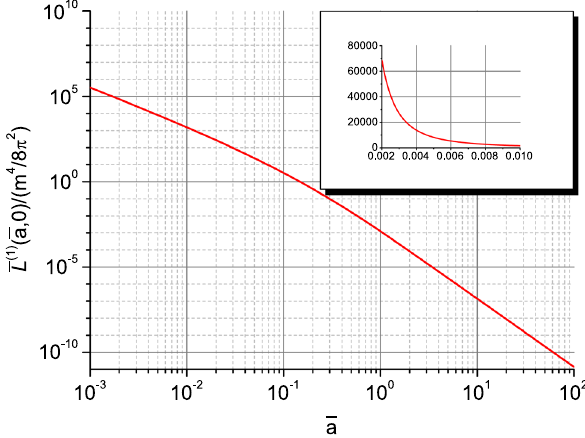
Fig. 2 Comparisonoftheintegralandclosedexpressionsof ¯ L ( 1 ) ( ¯ a , 0 ) . The integral expression is (5) with ˜ b = 0, and the closed one is (7). The plotted values are in units of m 4 / 8 π 2 . The parameter ¯ a ranges from 0.001 to 100, corresponding to B / B c from 500 to 0.005 for the purely magnetic case. The inset shows the values in linearscalefor the range of ¯ a from 0.002 to 0.01. The plots of the two expressions perfectly overlap each